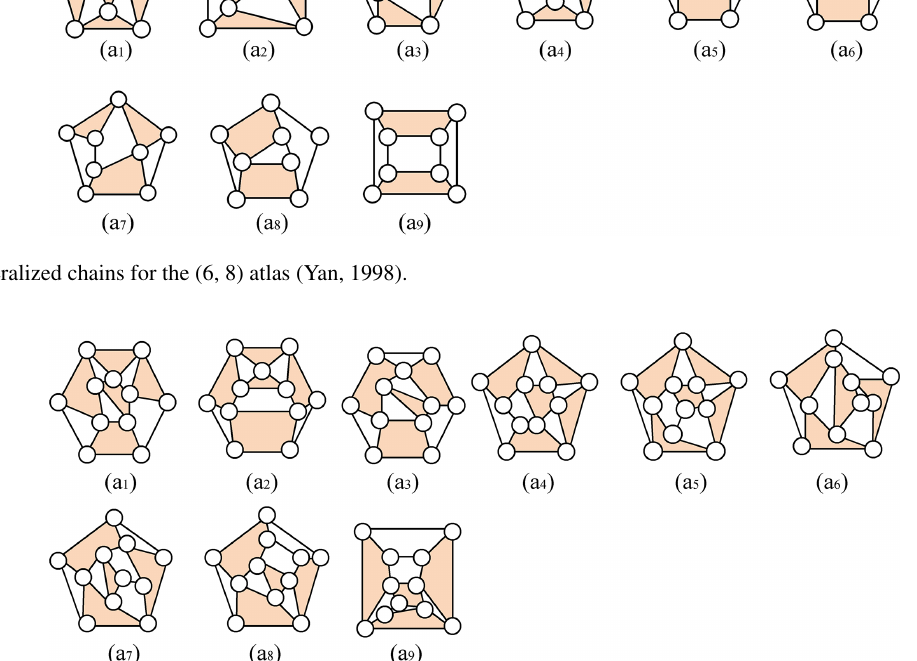
Figure 11. Some generalized chains for the (7, 11) atlas (Yan,